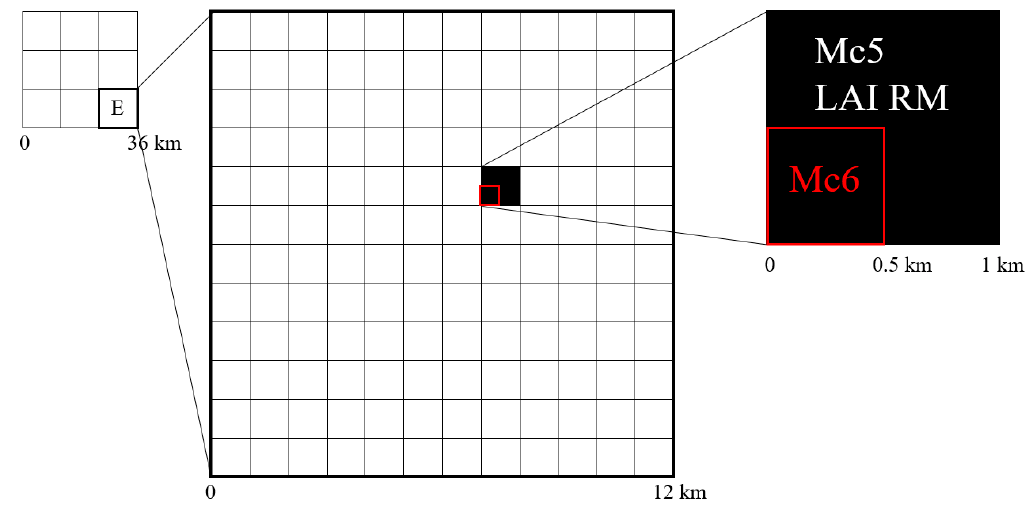
Figure 4. Scale comparisons for MODIS LAI (“Mc5” 1.0 km, “Mc6” 0.5 km), in situ LAI (“LAI-RM”